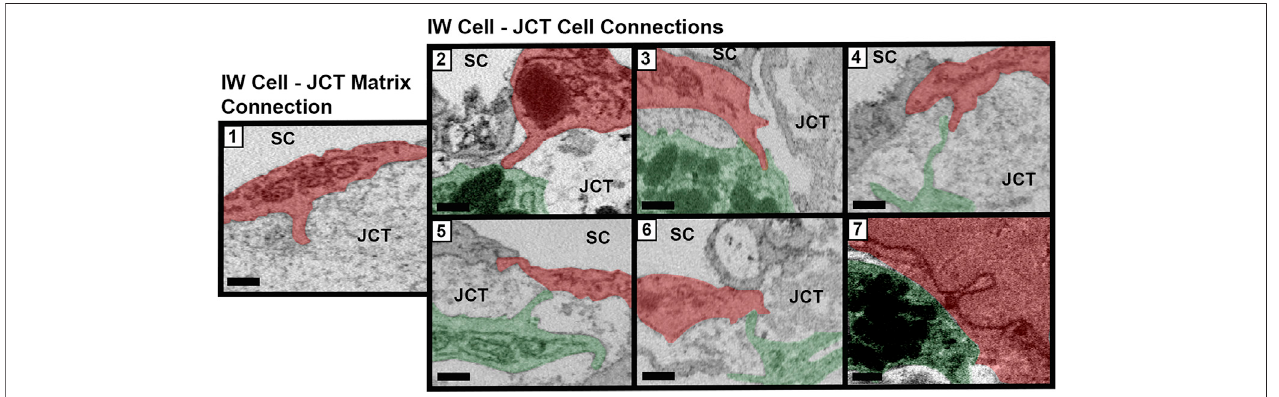
FIGURE 3 | Types ofcellular connections between IWendothelial cells and JCT cells/matrix. Types ofconnectionsbetweenthe inner wall(IW)endothelialcells ( red ) of Schlemm ’ s canal (SC) and underlying juxtacanalicular connective tissue (JCT) cells ( green ) and extracellular matrix. Type 1: IW cell process-to-JCT matrix; Type 2: IW cell process-to-JCT cell body; Type 3: IW tongue-in-JCT groove; Type 4: IW cell process-to-JCT cell process; Type 5: JCT process-to-IW-body; Type 6: JCT tongue-in-IW groove; and Type 7: IW body-to-JCT body. Scale bars = 0.5 µm.